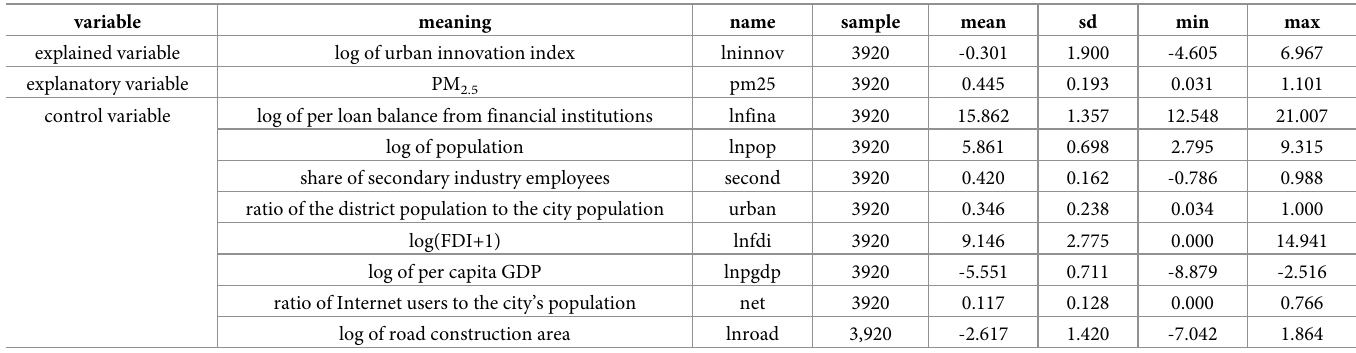
Table 1. Descriptive